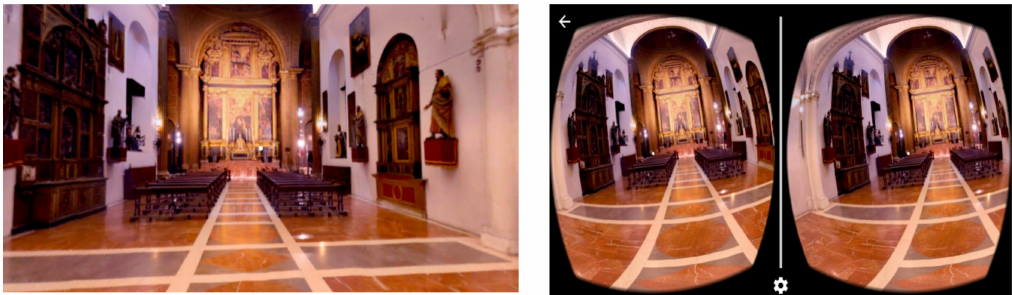
Figure 3. Images of the object produced at the Church of the